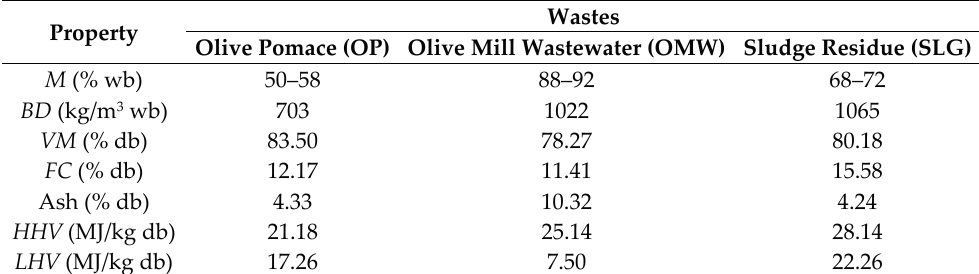
Table 2. Physical-energy characterization. wb, wet basis; db, dry